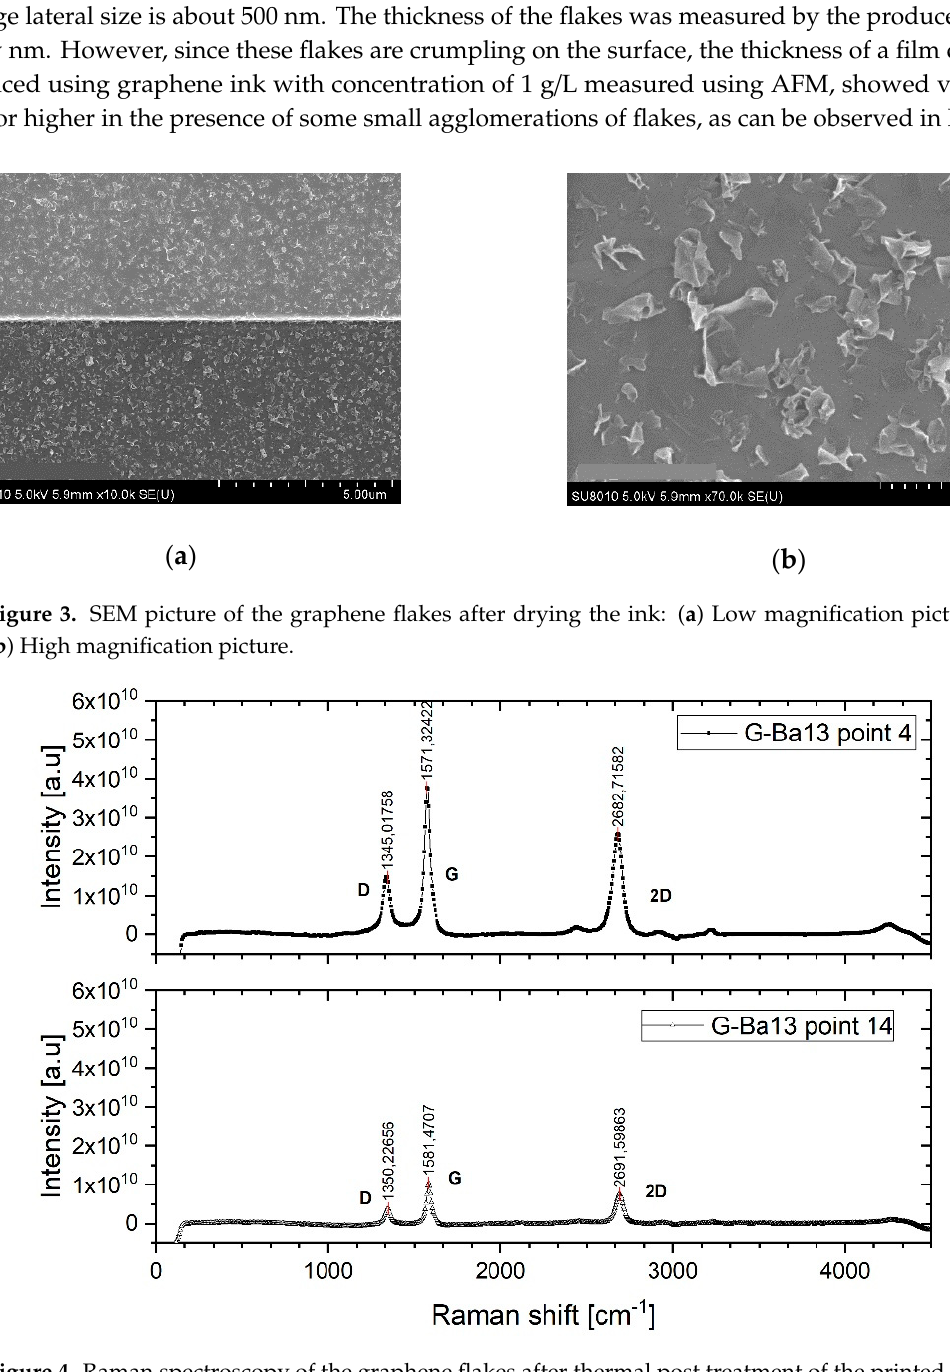
Figure 4. Raman spectroscopy of the graphene flakes after thermal post treatment of the printed ink, using a laser excitation of 532 nm.